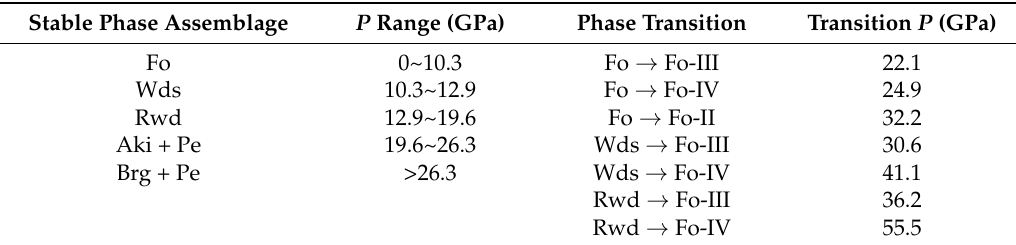
Table 5. P range of the thermodynamically stable phase assemblage for the Mg 2 SiO 4 composition and P for the polymorphic phase transition from Fo, Wds and Rwd to Fo-II, Fo-III and Fo-IV, based on our calculated enthalpies at 0 K (0–100 GPa; Figure